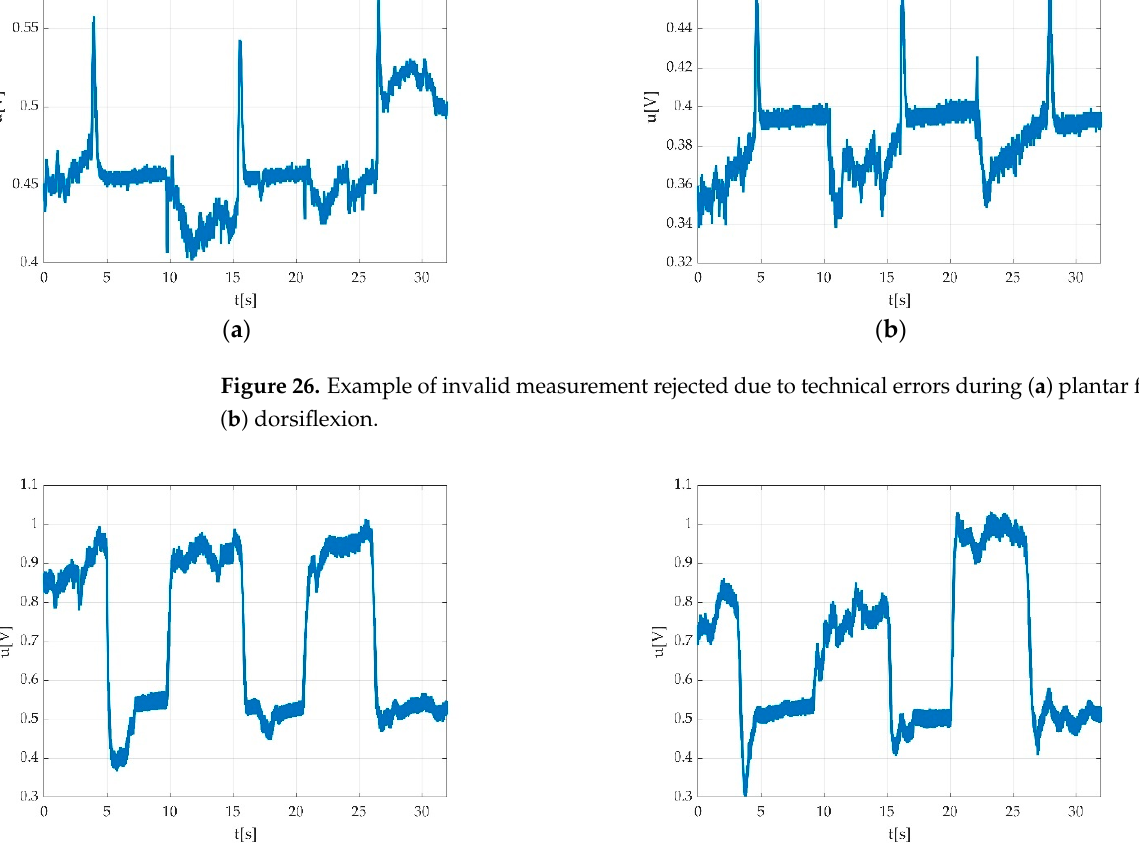
Figure 27. Example of invalid measurement due to: ( a ) impossibility to make automation detection of offset level; ( b ) participant inability to coordinate both muscle effort and relaxation period, which resulted in a time graph that does not permit an automatic detection of the offset level.